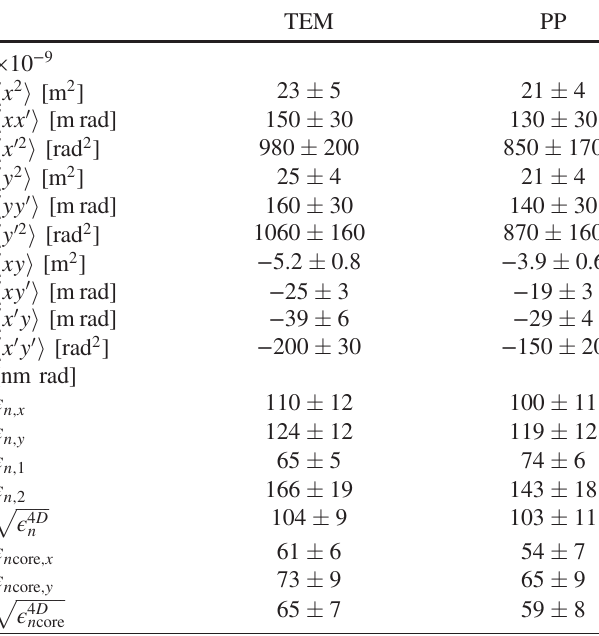
TABLE III. Results of the beam matrix elements and the projected, intrinsic and core emittances measured at the Pegasus beamline using TEM grid and pepper pot (PP) techniques for a 2.3 pC beam. The associated errors are calculated from the statistical variation between the different beam shots.